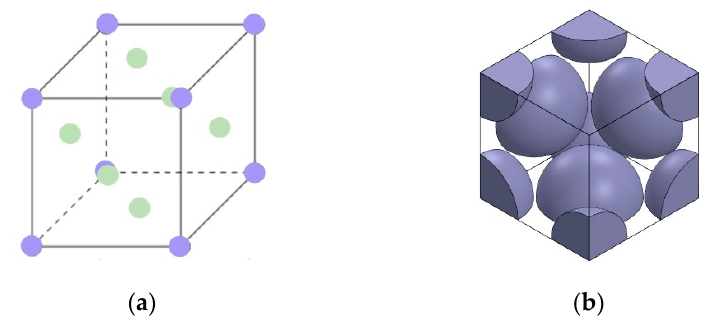
Figure 4. HCP structure. ( a ) Position of the centers of spheres; ( b ) Structure.